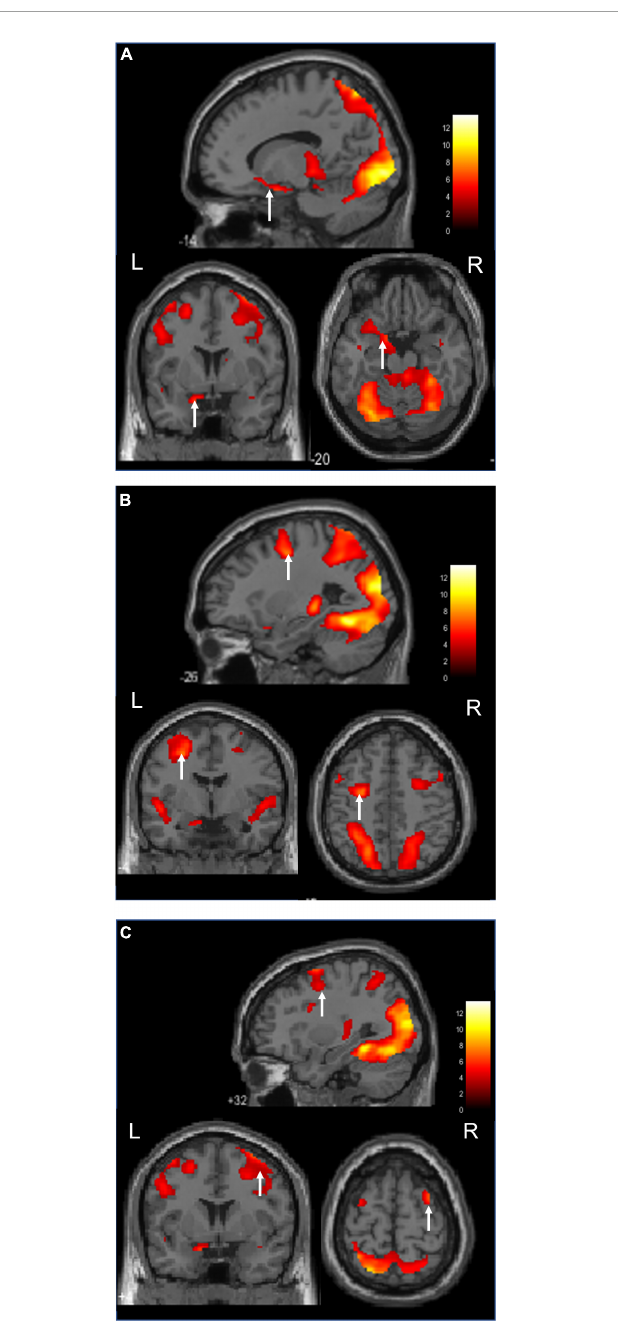
FIGURE3 Activation during the ASMR audiovisual stimulation task (Sagittal, coronal, and axial images.). (A) Activation of the left nucleus accumbens is confirmed. (B) Activation of the left middle frontal gyrus is confirmed. (C) Activation of the right middle frontal gyrus is confirmed.